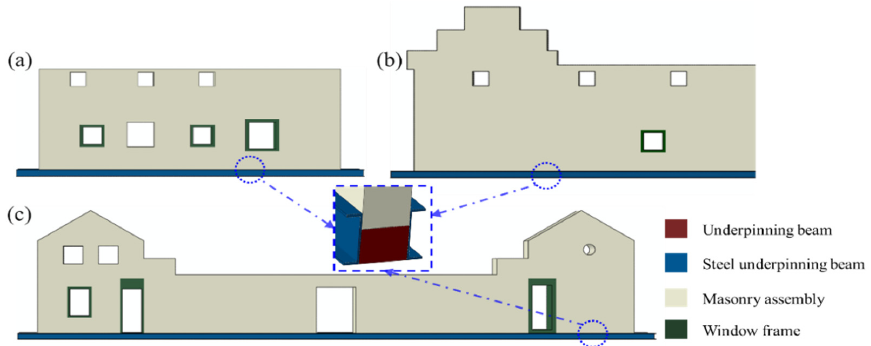
Figure 5. FE models of exterior walls: ( a ) west side, ( b ) north side, and ( c ) south side.